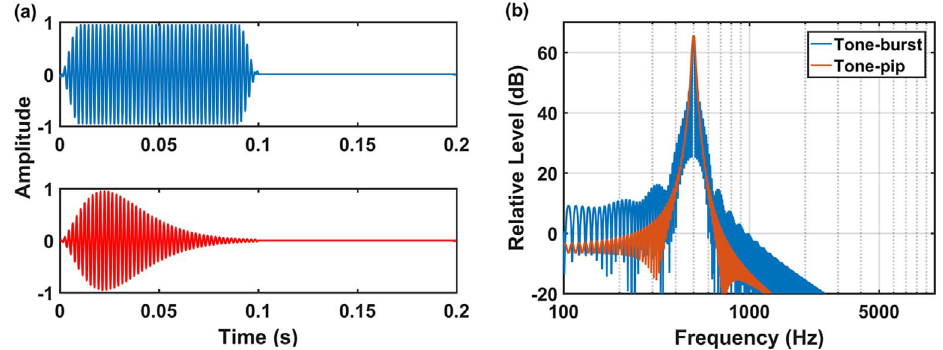
Figure 1. (a) A tone-burst and a tone-pip of frequency 500 sHz. The envelope of the tone-burst corresponds to a rectangular window of 0.1 ms. The ( a , c ) parameters of the tone-pip are (90, 3). (b) The corresponding log-spectra.